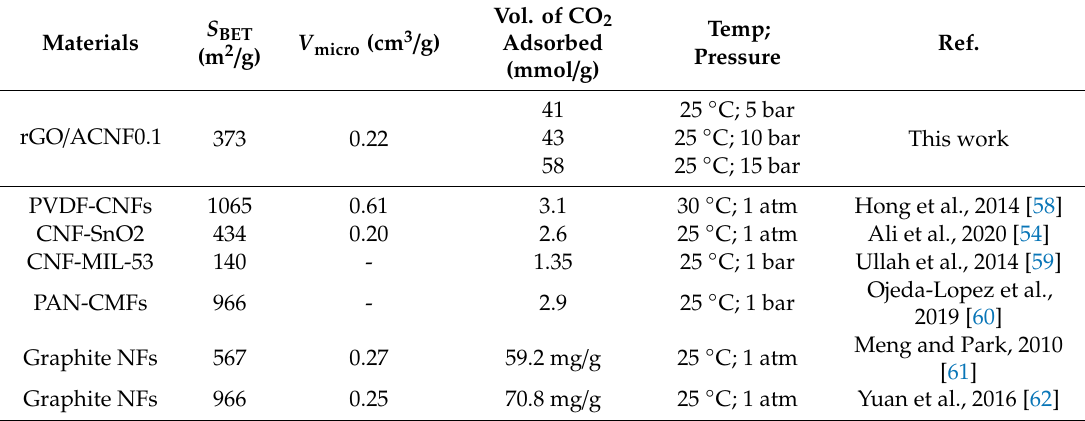
Table 3. Comparison of CO 2 adsorption capacity on various types of carbon fibers and their composite-based